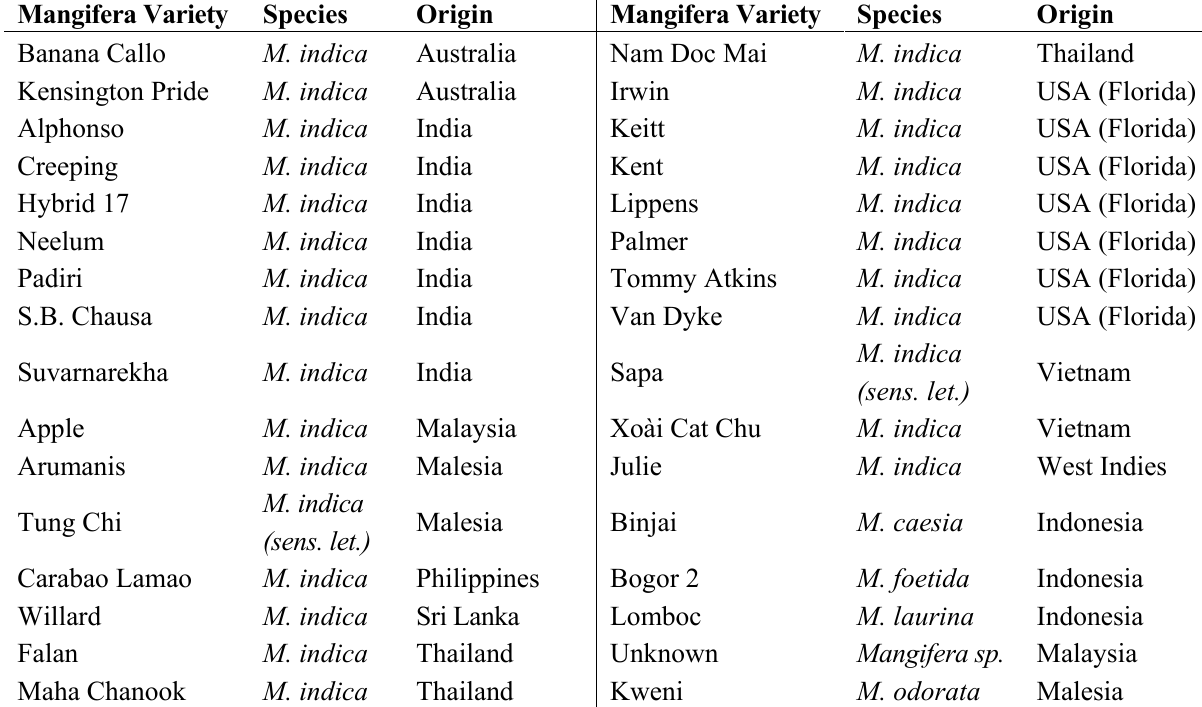
Table 1. Country of origin of 32 Mangifera varieties used in the evaluation of mango expressed sequence tag-simple sequence repeat (EST-SSR) microsatellite